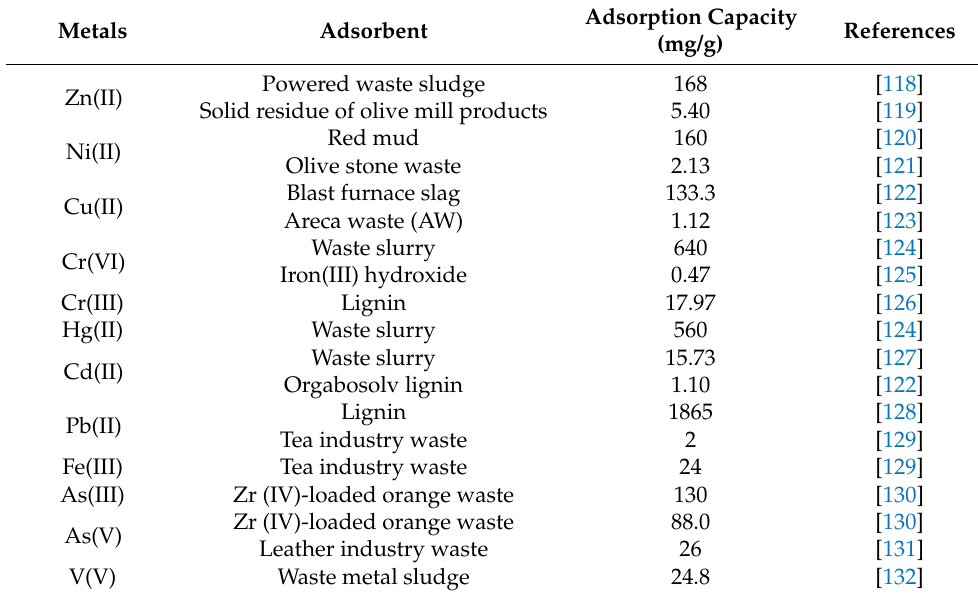
Table 3. Reported literature summary of the adsorption of metals in industrial